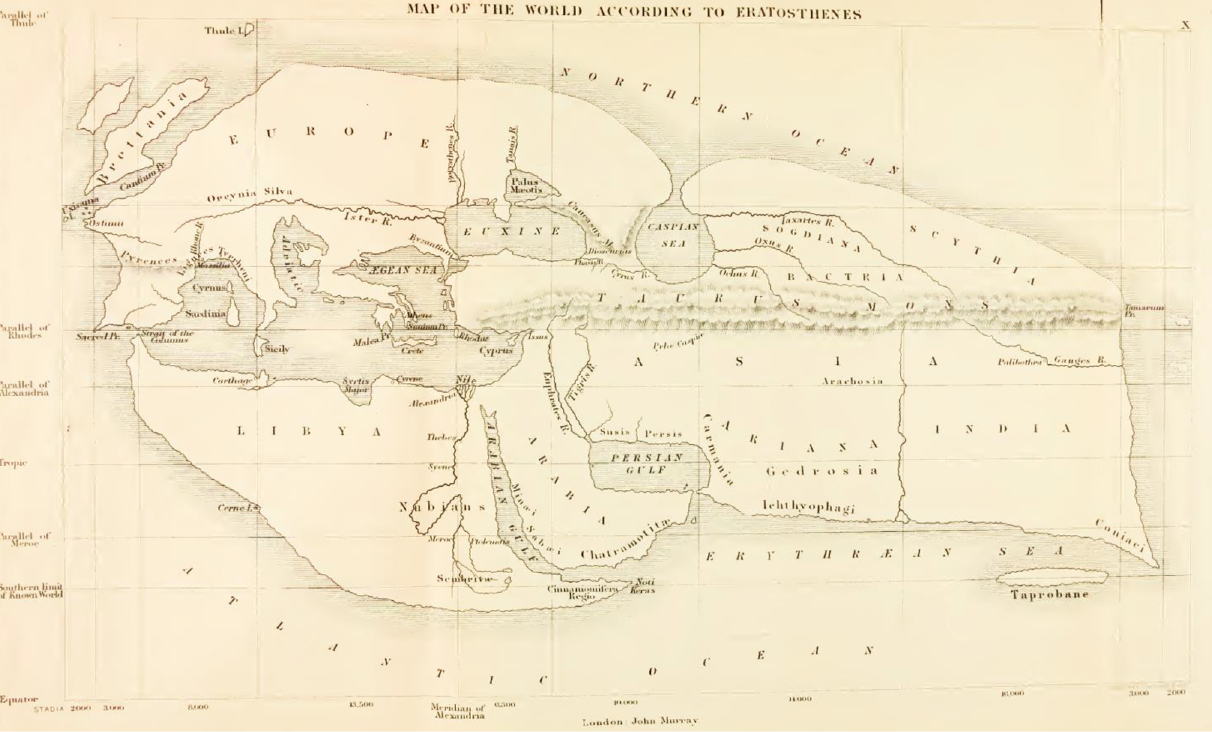
Figure 15. Map of the world according to Eratosthenes (reproduced from Bunbury,